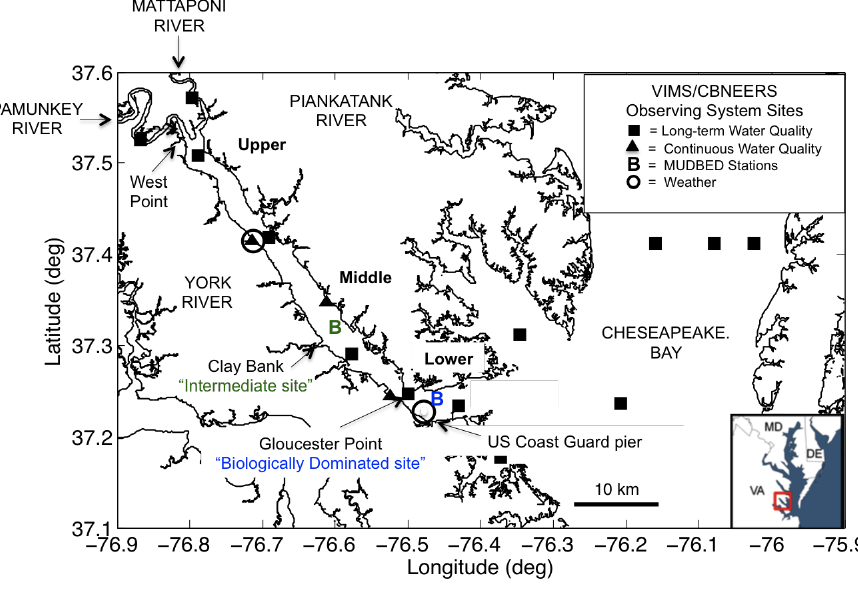
Figure 1. Map of York River estuary, southeastern VA, USA. The location of the Multidisciplinary Benthic Exchange Dynamics (MUDBED) Intermediate site is in green and MUDBED Biologically Dominated site is in